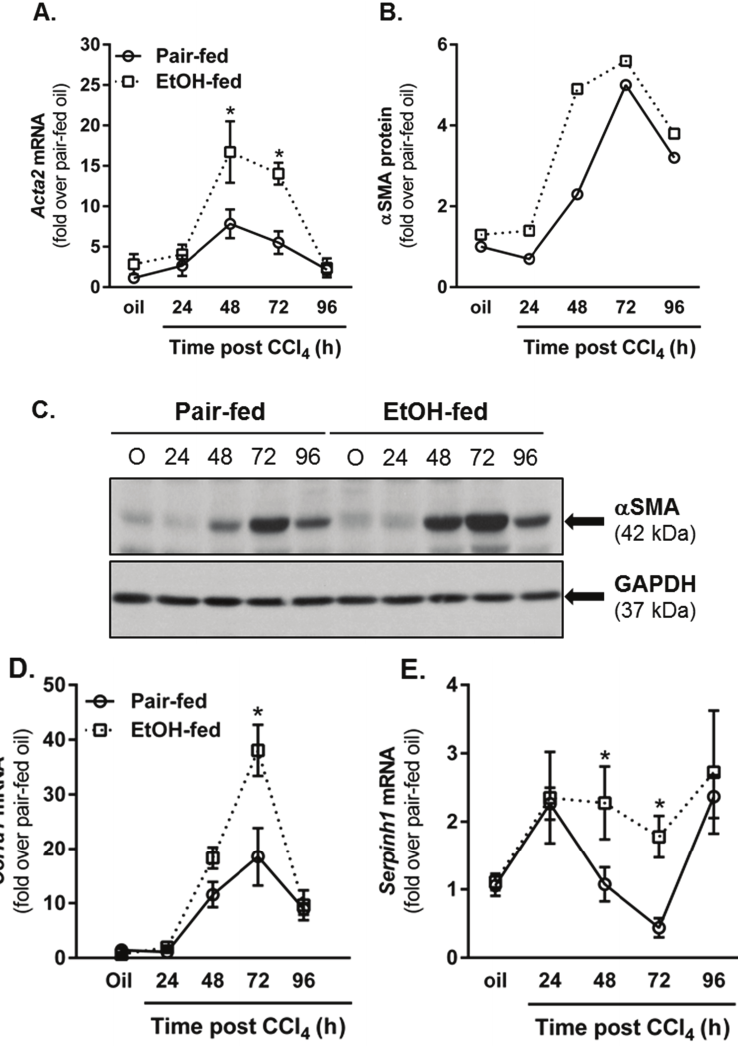
Figure 10. Moderate ethanol feeding enhanced hepatic stellate cell (HSC) activation